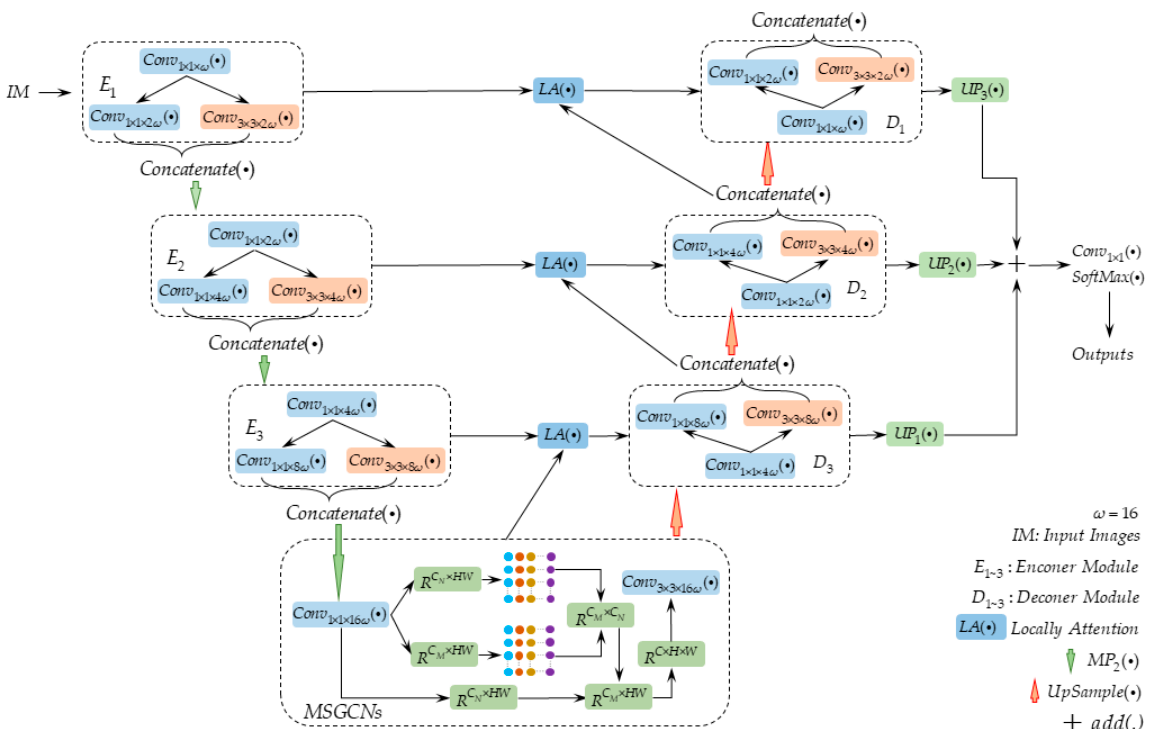
Figure 3. Overall structure of the segmentation framework. IM is the original remote sensing image, E 1,2,3 is the encoder, D 1,2,3 is the decoder, Conv 1 × 1 × ω is the convolution operation with a convolution kernel of 1 × 1, and ω is the filter. Conv 3 × 3 × 2 ω is a 3 × 3 convolution operation with a filter of 2 ω , where ω is 16. LA( · ) is the local attention module. Concatenate( · ) is the matrix concatenation; SoftMax( · ) is the classifier; C , H , and W are the channel, height, and width of the feature, respectively. “ UP ” indicates the upsampling operation of bilinear interpolation, where UP 1 ( · ) indicates that the upsampling kernel size is 8 × 8 and UP 2 ( · ) indicates that it is 4 × 4. UP 3 ( · ) indicates that the upsampling kernel size is 2 ×